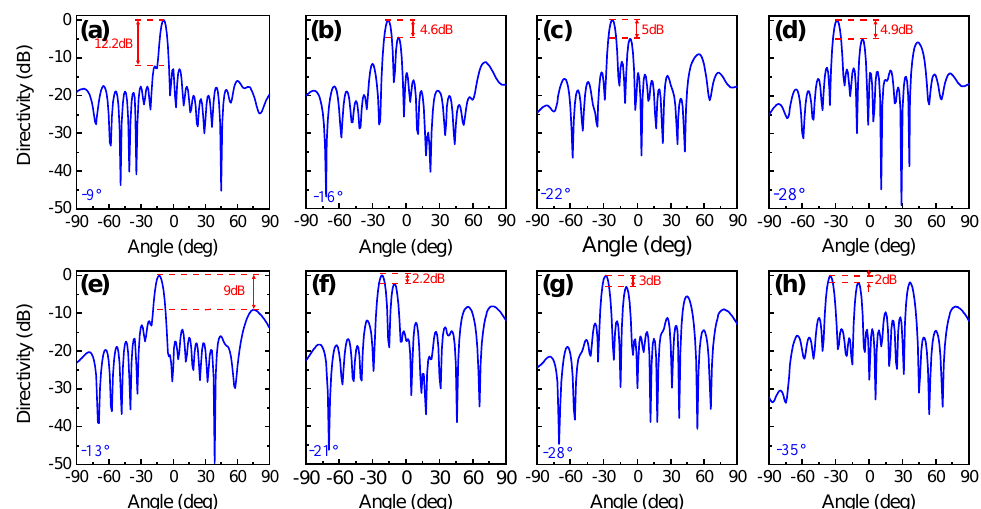
Figure 7. Far-field directivity for the deflected reflection angle of ( a , e ) θ = − 5 ◦ ; ( b , f ) θ = − 11 ◦ ; ( c , g ) θ = − 17 ◦ ; ( d , h ) θ = − 23 ◦ under oblique incident angles of ( a – d ) 5 ◦ ; and ( e – f ) 10 ◦